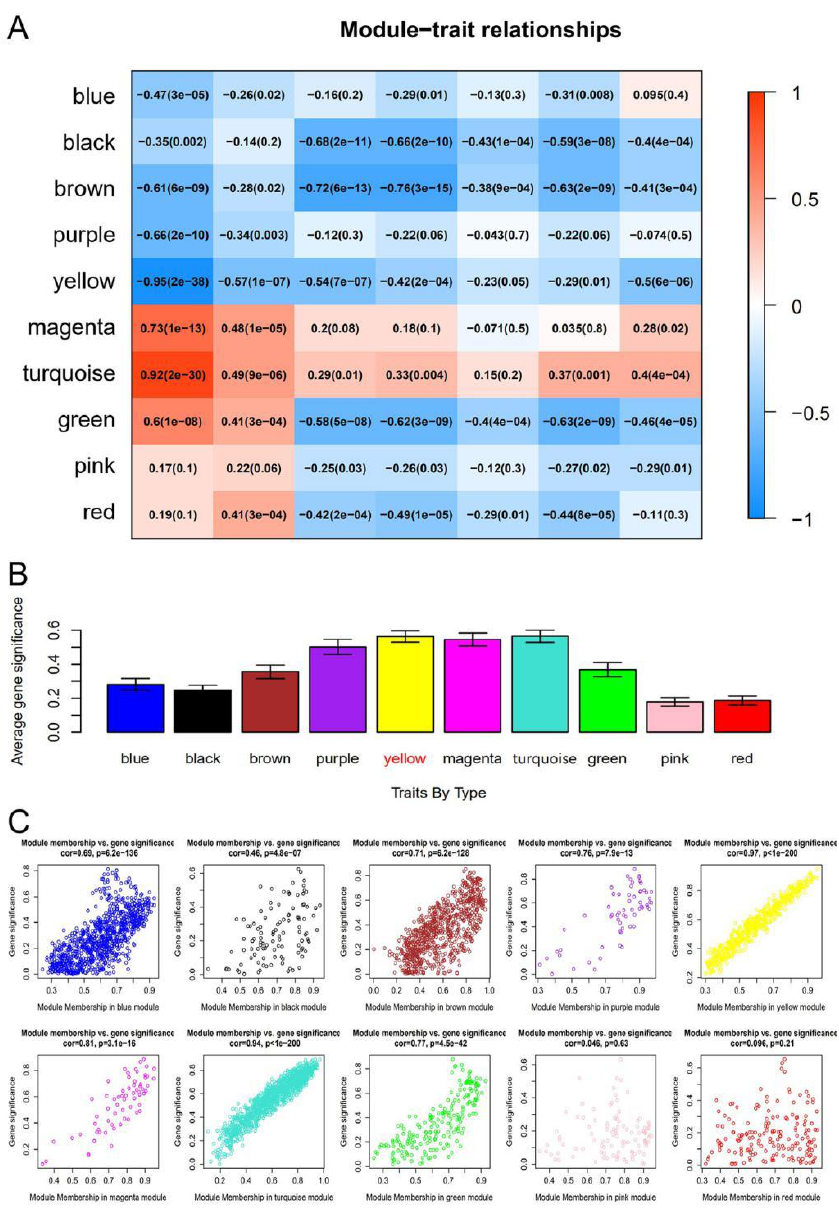
Figure 3. Identification of modules associated with tissue types. ( A ) Heatmap of the correlation between module eigengenes and clinical traits. Red means positive correlation, blue means negative correlation, and the darker the color, the close the absolute value is to 1, and the stronger the correlation. ( B ) Distribution of average gene significance and errors in the modules associated with tissue type. The x-axis indicates the module, the y-axis indicates the significance of overrepresentation. ( C ) Scatter plots of the degree and P -value of Cox regression in dataset. The x-axis indicates the degree of regression, the y-axis indicates the gene significant. Each circle represents a gene.